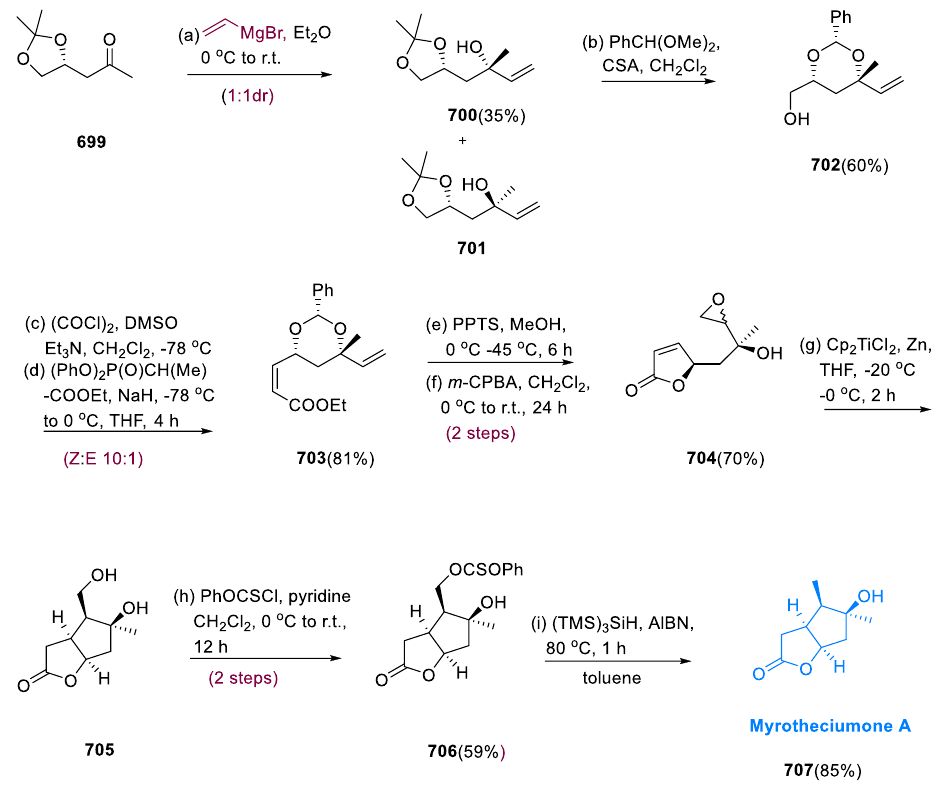
Scheme 42. Total synthesis of myrotheciumone